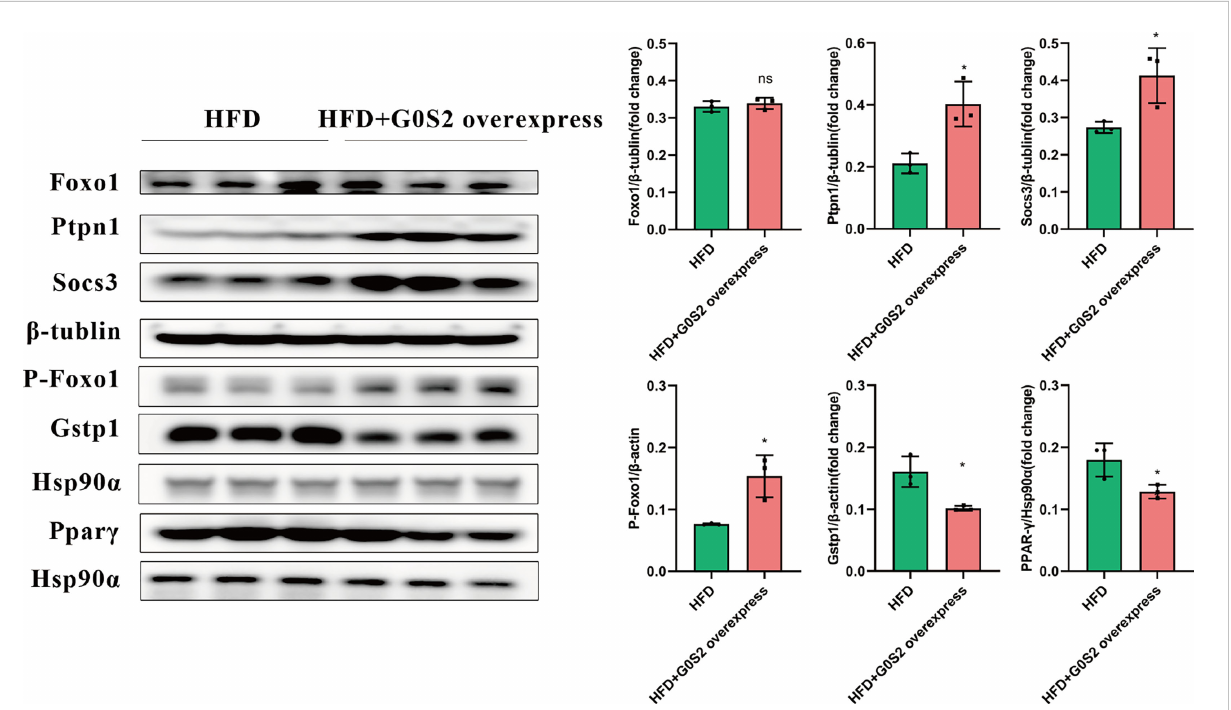
FIGURE 6 Insulin resistance was evaluated using western blotting and RT-PCR analysis. Upregulation of phosphatase Foxo1, Socs3, and Ptpn1, and downregulation of Gstp1 and PPAR- g in the livers of HFD- G0S2 overexpression mice were determined by western blotting and RT-PCR in liver tissue. The experiment was repeated three times, using three independent batches of mice and three independent mice in each group.